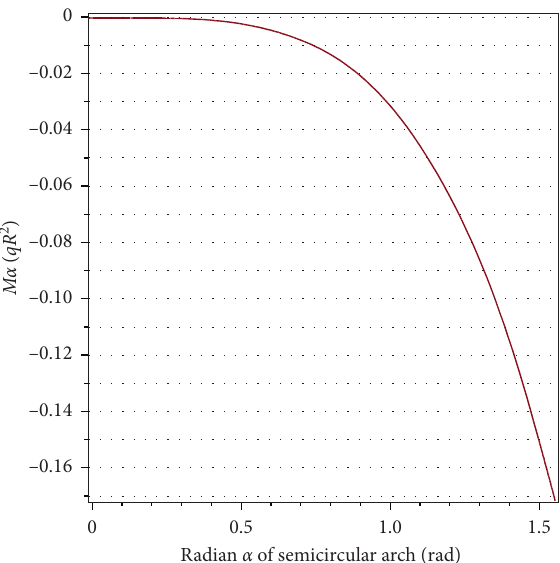
Figure 8: Relationship between bending moment and angle of a semicircular arch.